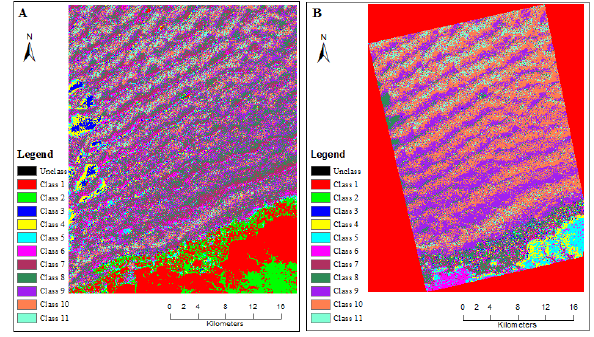
Figure 5: K-Means, Unsupervised Classification, Image for Landsat (A) and Worldview (B) Figure 7: Supervised Classification Images: Landsat: Maximum Likelihood (A1); Minimum Distance (A2) and Worldview: Maximum Likelihood (B1); Minimum Distance (B2).